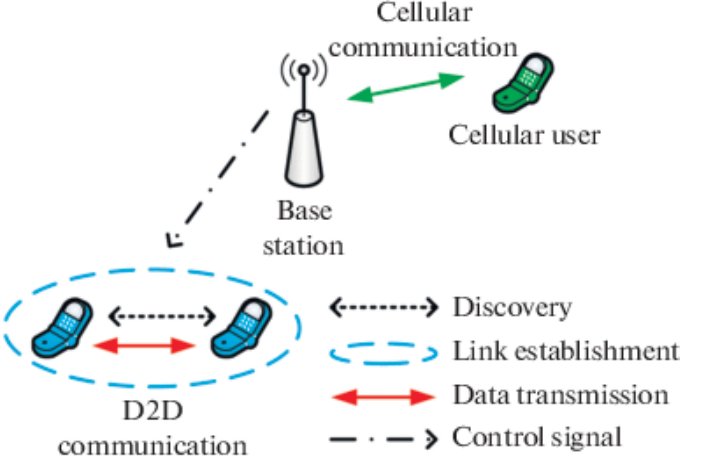
Figure 1. Resource allocation for D2D communications in wireless networks (Green arrow represents the communication channel) .